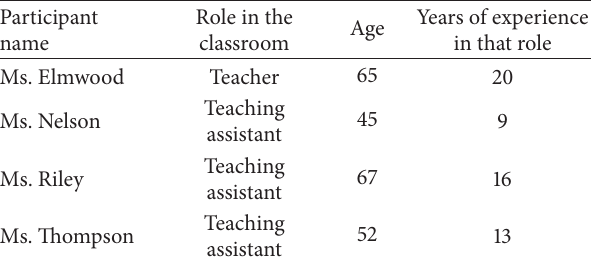
Table 1: Participants’ demographic